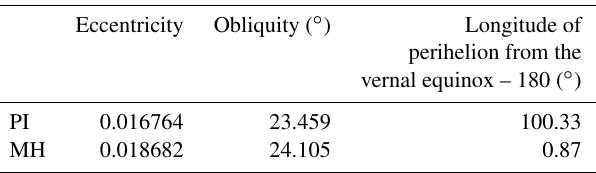
Table 1. Orbital configurations for the PI and MH experiments. The PI and MH values here represent the values for the years 1850CE and 6000 years before 1950CE, respectively, taken from the PMIP3 web page (PMIP3, 2019). They originate from Berger (1978). Pa- rameters for PI may vary slightly with the